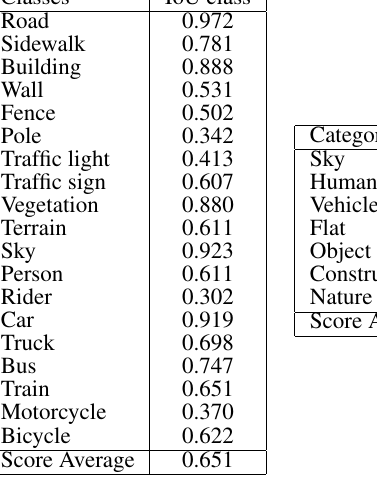
Table 1. PSPNet performance on Cityscapes validation set: Left: Class - wise; Right: Category - wise